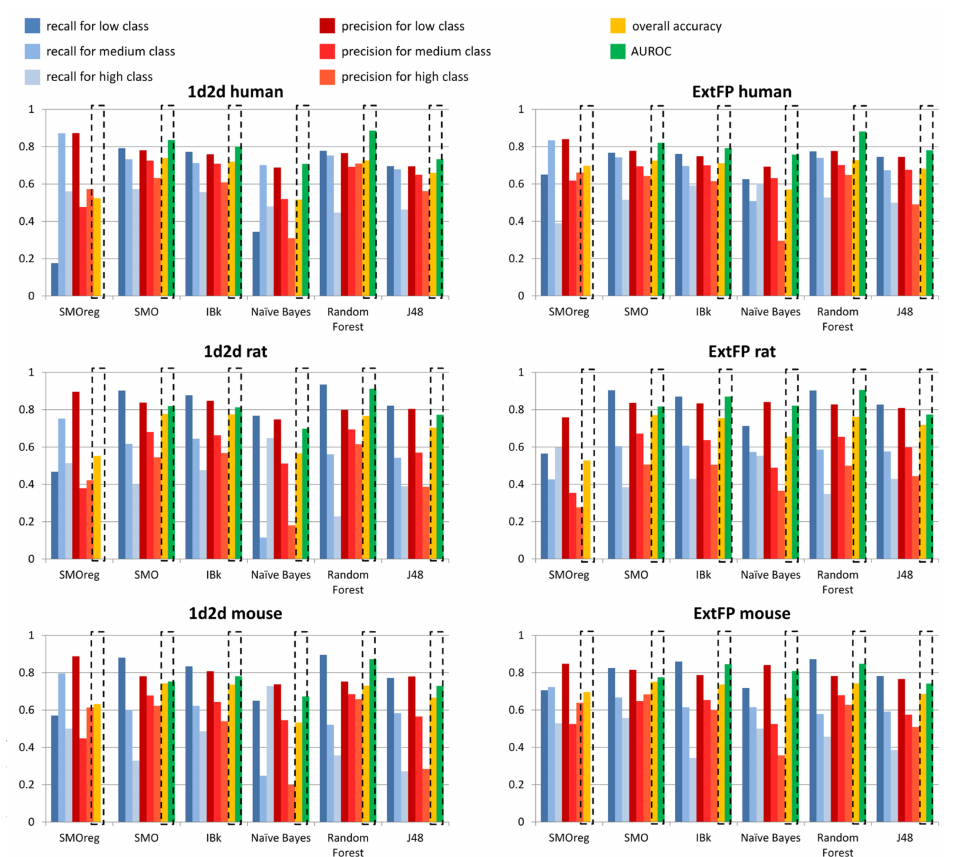
Figure 7. Visualization of evaluating parameters values obtained in 10-fold CV studies (T 1/2 liver microsomes